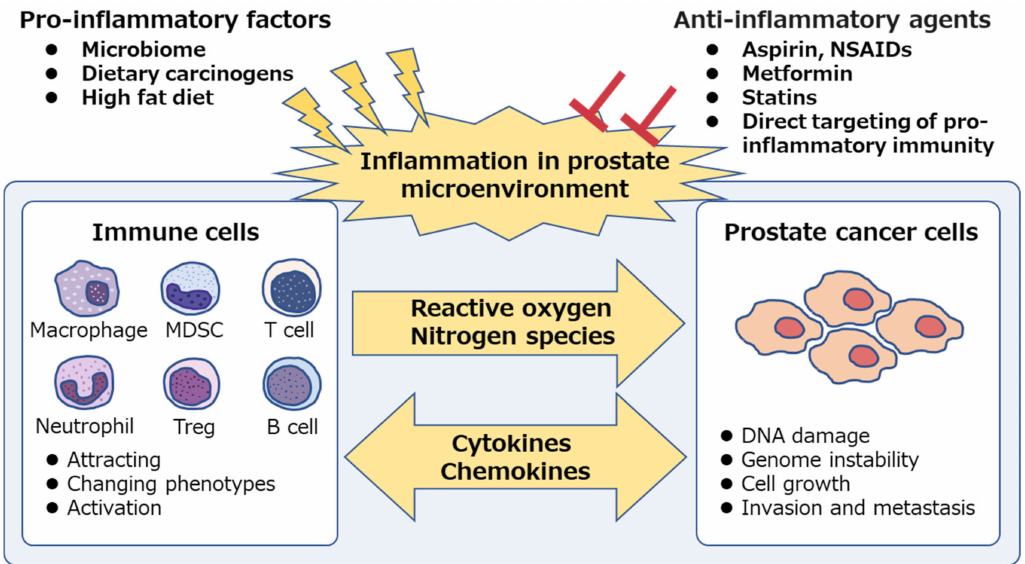
Figure 1. Chronic inflammation is associated with prostate cancer. Pro-inflammatory factors, such as microbiome and dietary components, are the potential cause of prostatic inflammation. Immune cells secrete reactive oxygen and nitrogen species, induce DNA damage and genome instability in prostate epithelium and cause prostate cancer development. Both immune cells and prostate cancer cells secrete intercellular signaling molecules, such as cytokines and chemokines, and contribute to the generation of inflammatory microenvironment, which facilitates cancer progression. Anti-inflammatory agents suppress the “vicious cycle” and inhibit prostate cancer development and progression. NSAIDs, non-steroidal anti-inflammatory drugs; MDSC, myeloid-derived suppressor cell; Treg, regulatory T